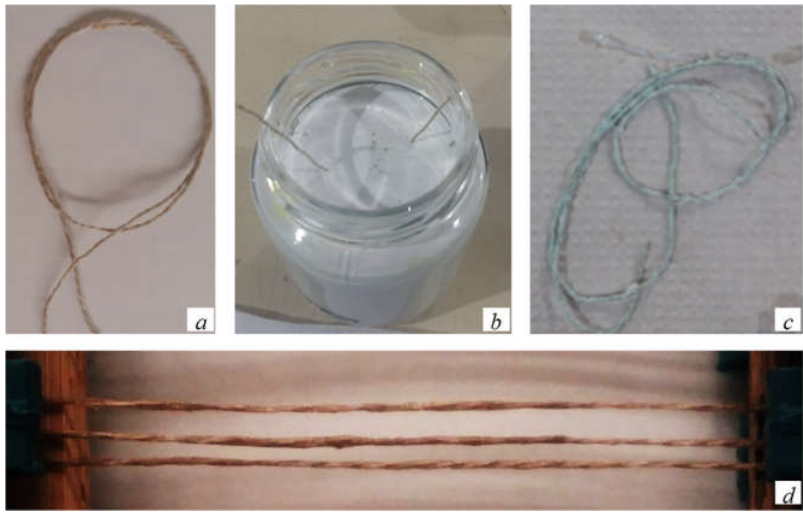
Figure 2. Fibers impregnation procedure: ( a ) flax yarn; ( b ) yarn immersion; ( c ) embedded yarn; ( d ) yarns drying.